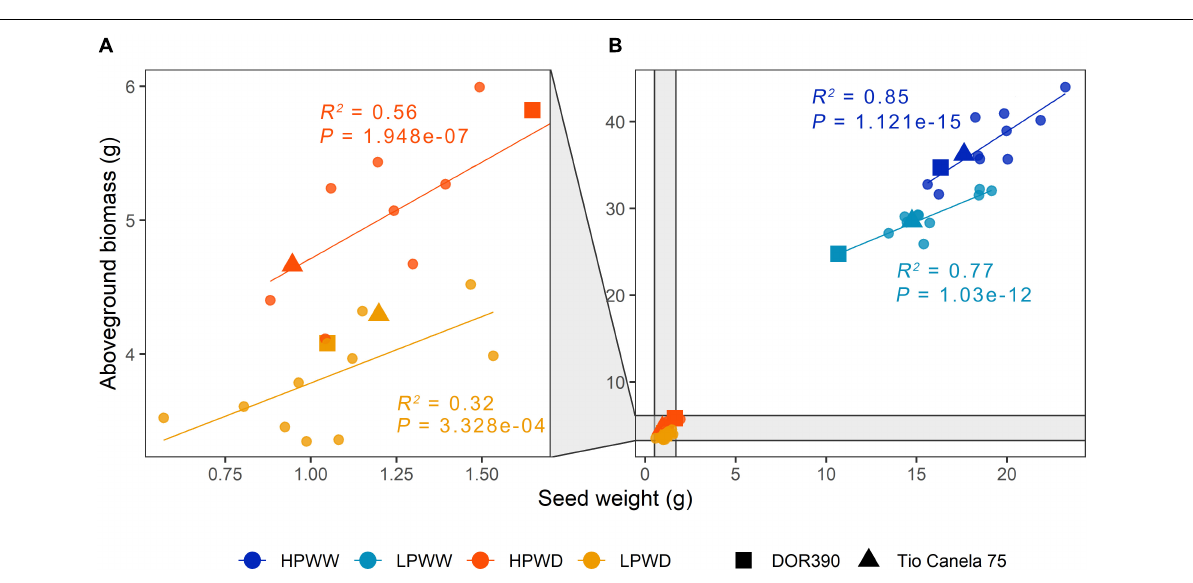
( P = 0.000) lower δ 13 C in leaf tissue at flowering ( − 28.65) and mid pod fill ( − 28.09) compared to seed at harvest ( − 25.35) ( Figure 4 and Supplementary Table 5 ). No variation between